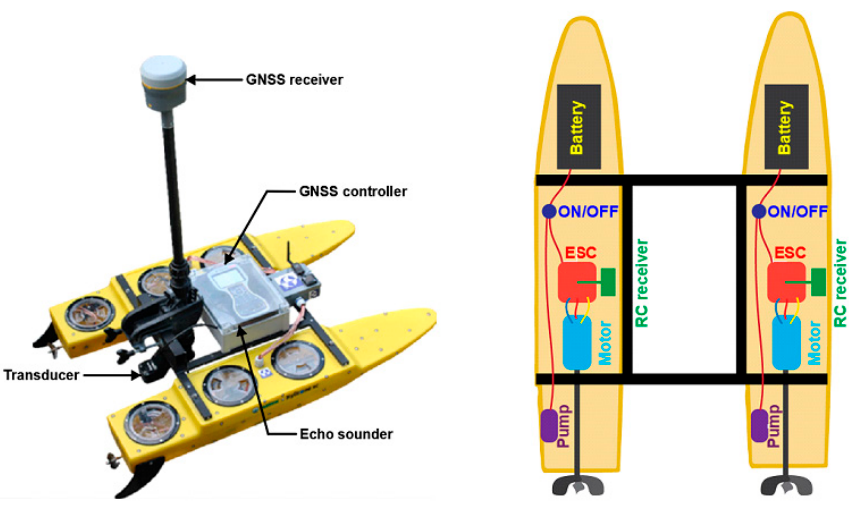
Figure 12. Unmanned surface vessel (USV) with measuring equipment mounted on it.